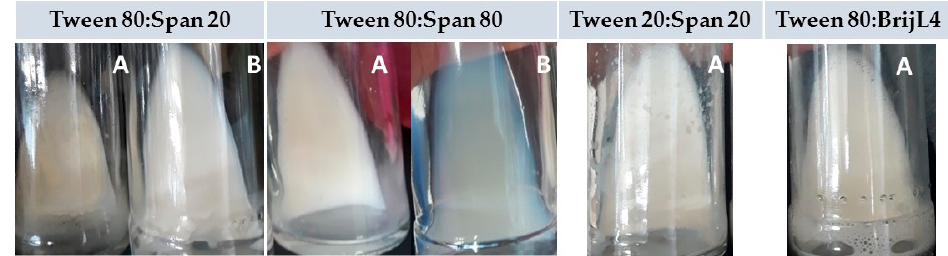
Figure 3. Emulsions of the Cedrela odorata essential oil with different binary mixtures of surfactants of HLB = 10.46 and a 10:15:75 (essential oil:surfactant:water) ratio: (A) emulsions prepared with magnetic stirring and heating; and (B) dispersion of oil droplets using ultrasound in cycles of 2